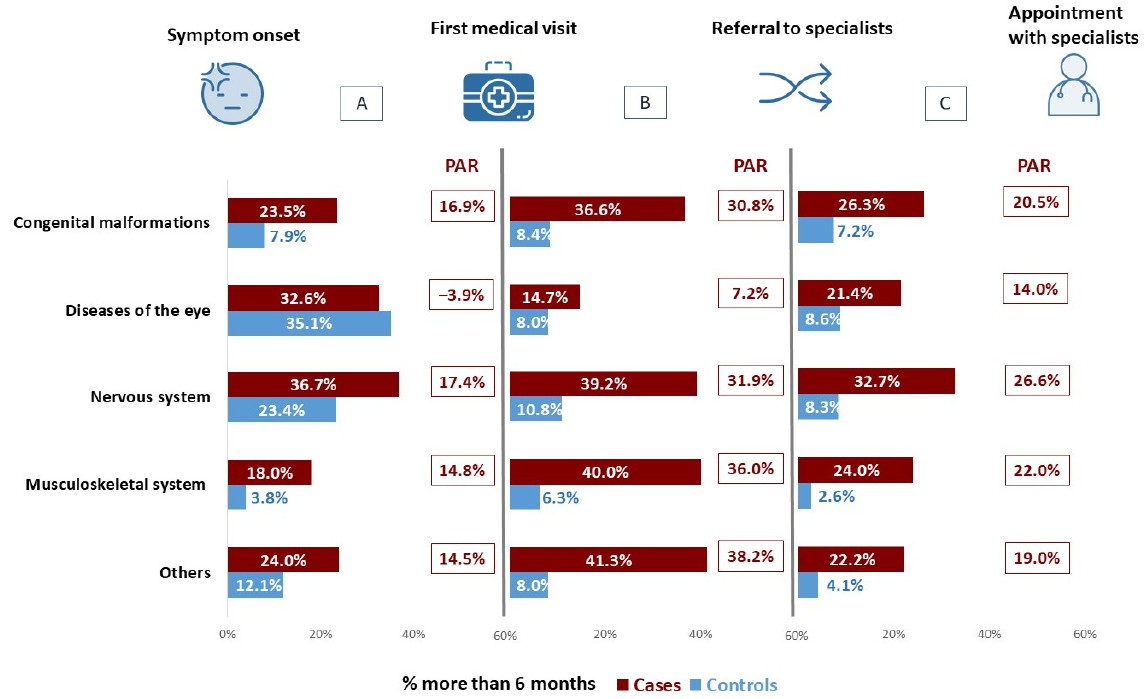
Figure 2. Percentage of RD-affected persons who took more than 6 months: ( A ) from symptom onset to first medical visit; ( B ) from first medical visit to referral to specialist; ( C ) from referral to appointment with specialist. PAR: Population Attributable Risk.